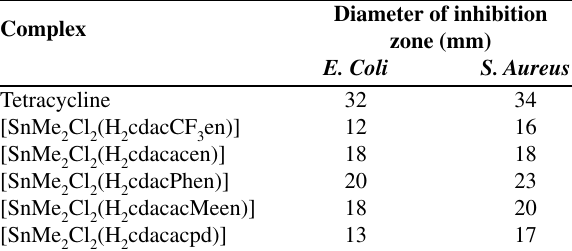
Table 4. The antibacterial activity data of the Sn(IV) Schiff base complexes Complex